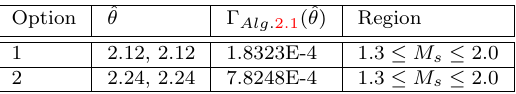
Table 2: Settings for the δ -tuning PID parameters c and γ in Alg. 2.1 and Eq. (27) in Di Ruscio and Dalen (2017). row 1) optimized over the robust region and 2) over the entire region.